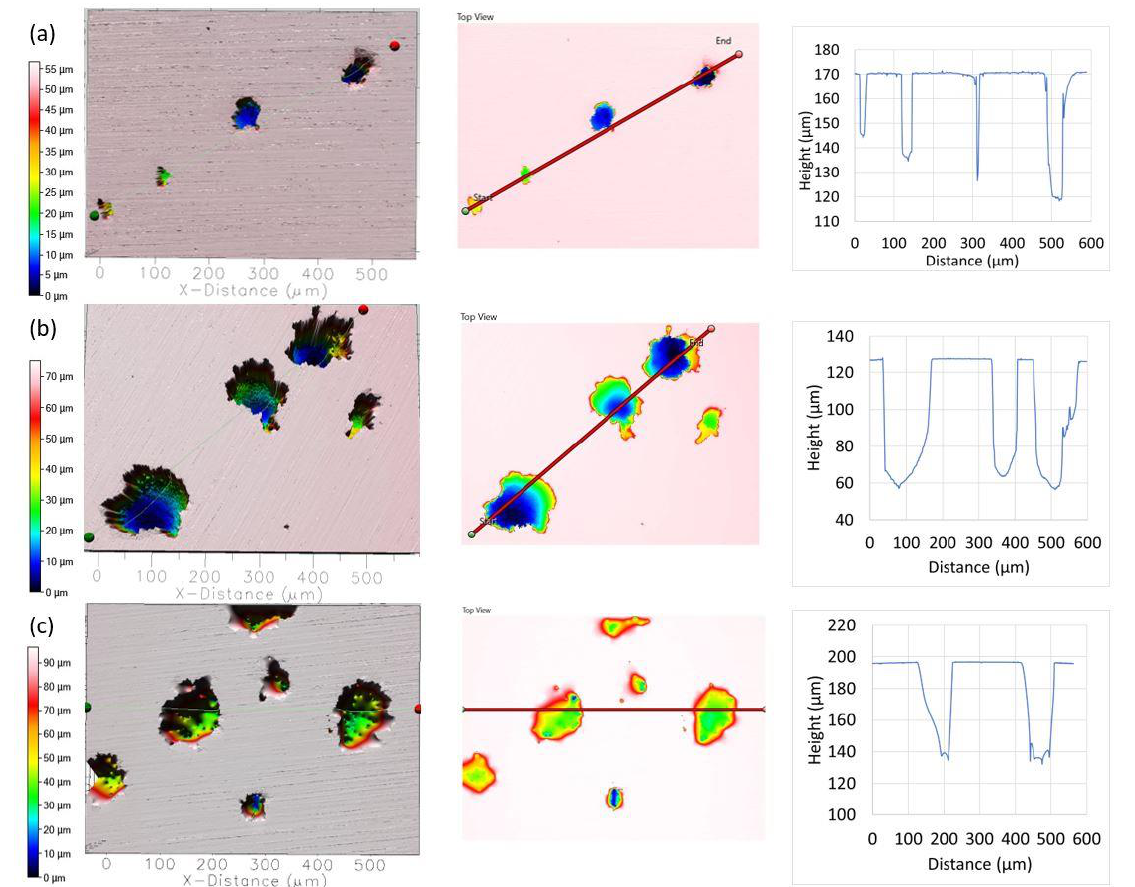
Figure 13. Topographic view of the segment of the corroded AISI 304L surface after potentiodynamic polarization measurement in seawater at ( a ) 288 K, ( b ) 298 K, and ( c ) 308 K. The depth and width of pits are determined along the red lines.